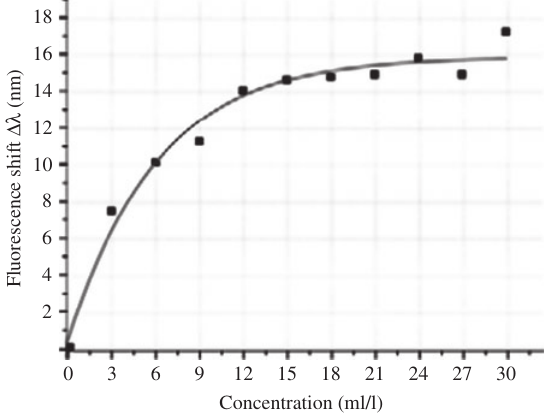
Fluorescence shift as a function of Arelon fl ü ssig con- centration, conducted by applying pesticide droplets on an ivy leaf coated with a rhodamine 6G layer. Measurement was performed using a LIF system with nitrogen laser as excitation source at 337 nm ( Hake et al. 2007 ).